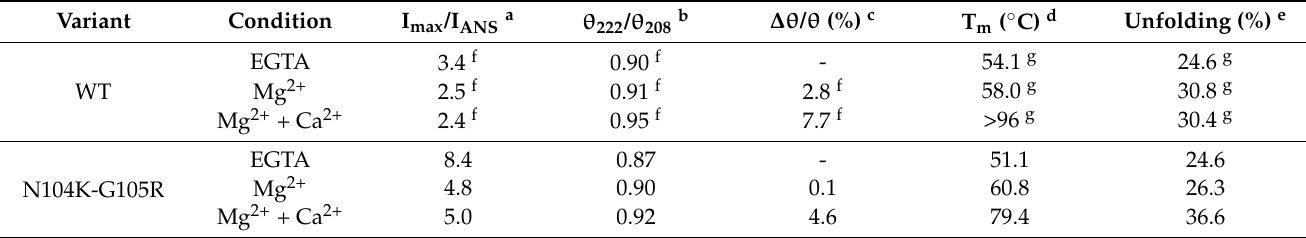
Table 3. Effects of cation binding on secondary structure, hydrophobicity, and thermal stability of GCAP1 variants monitored by Circular Dichroism (CD)